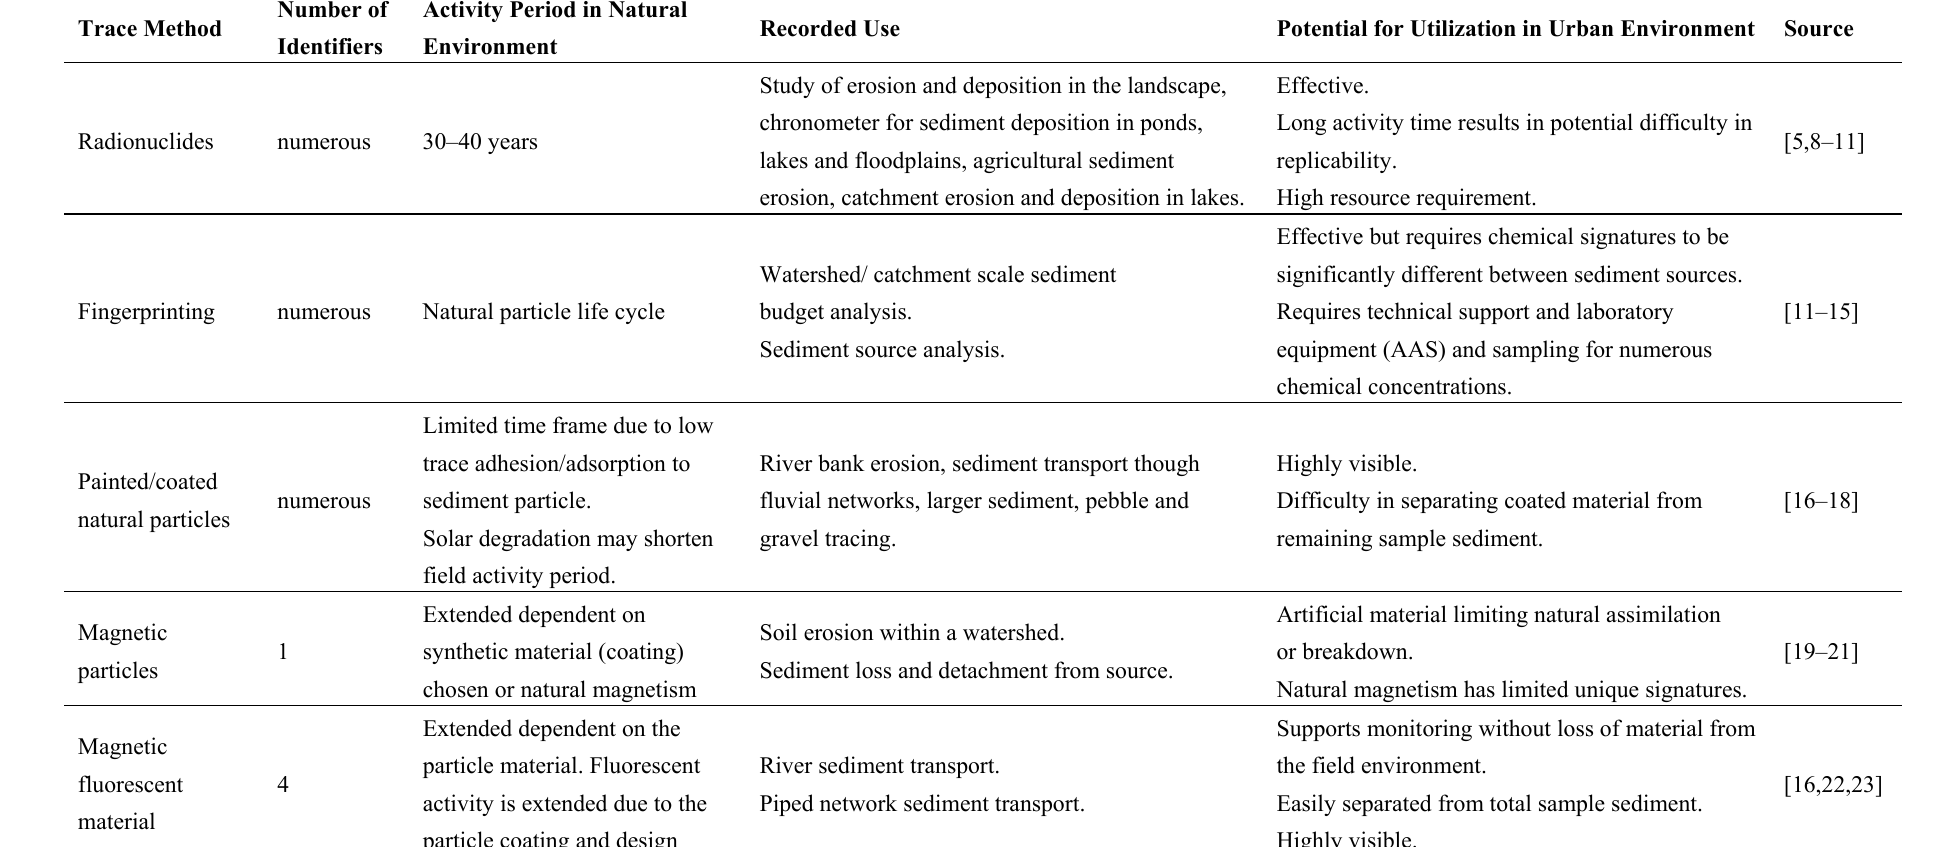
Table 1. Overview of sediment tagging